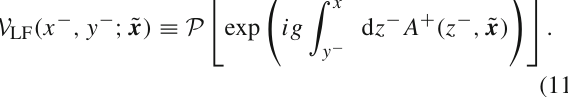
W ( x ) = 1 + i g F μν ( x ) d x μ ∧ d x ν . When the path (cid:2) 2